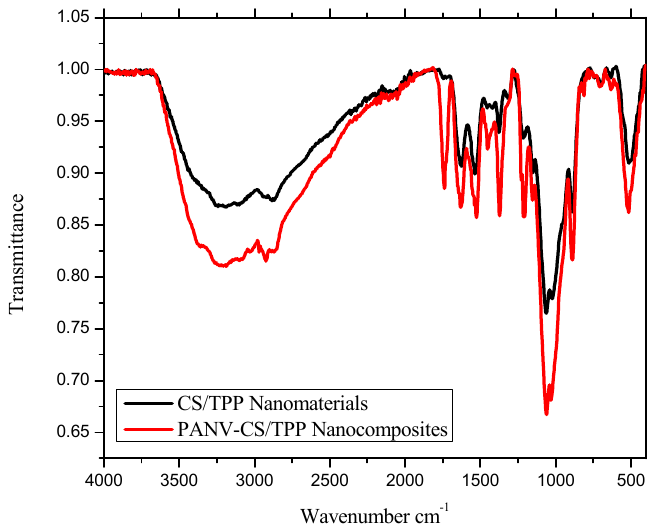
Figure 4. FTIR spectra of free CS/TPP nanomaterials and PANV-CS/TPP nanocomposites.